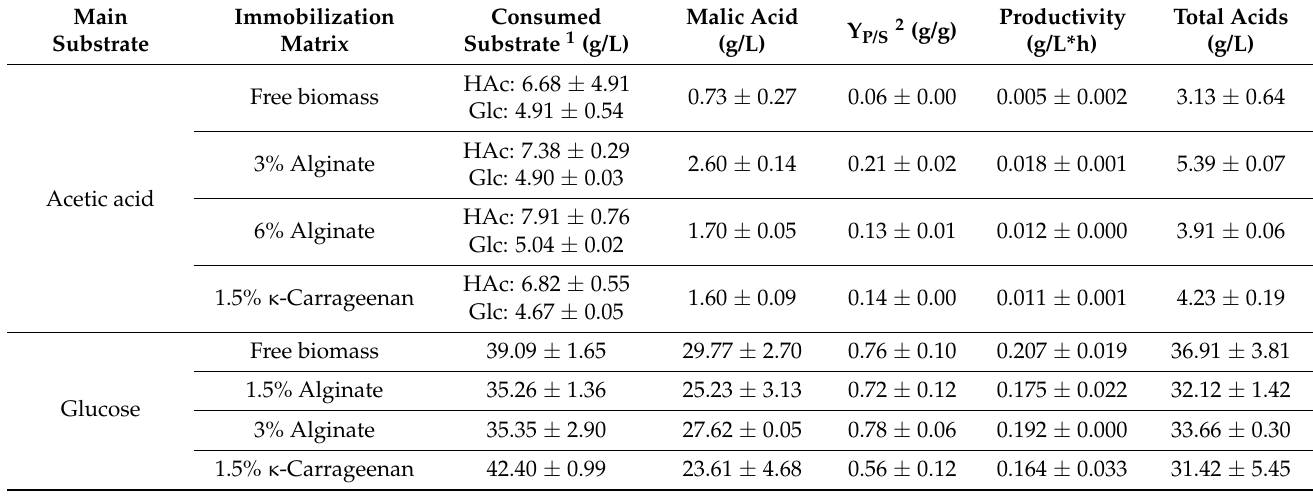
Table 2. Fermentation results for 2.5-L bioreactor cultivations of A. oryzae after 144 h. Values are means of duplicates with standard